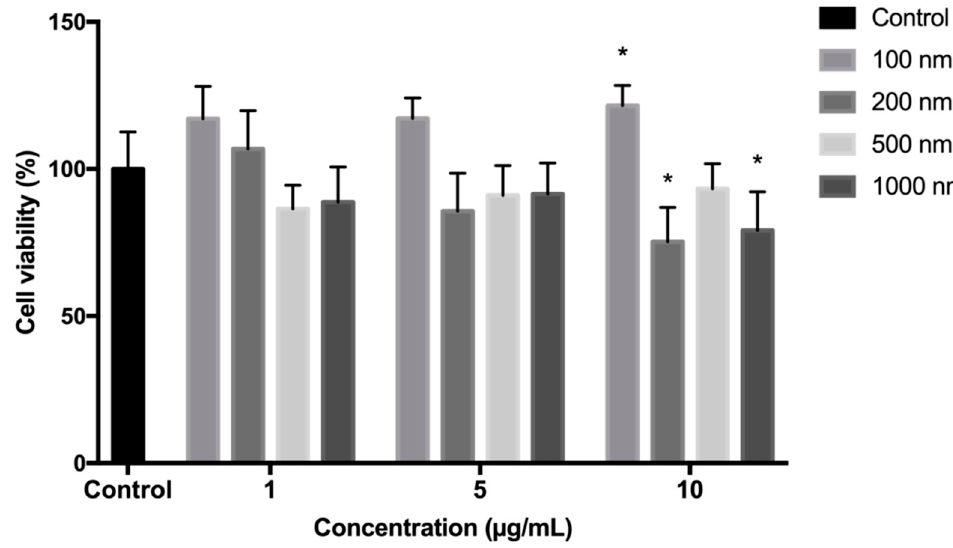
Figure 1. The effects of polystyrene particles (at increasing diameters) on cell viability measured by MTT assay. HSF were exposed to 1, 5 and 10 µg/mL of particles for 24 h. * p < 0.05 related to the untreated control group, using one-way ANOVA followed by Dunnett’s test.